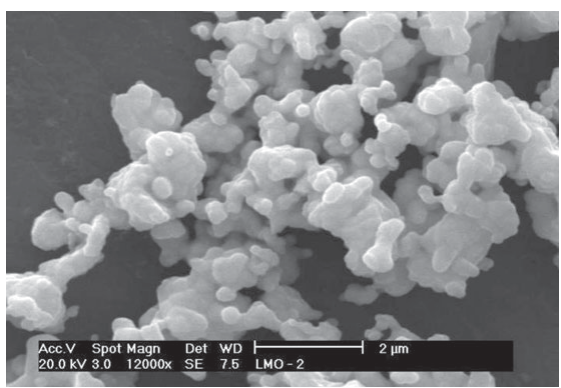
Figure 6. SEM micrograph of the LaCr synthesized by combustion reaction